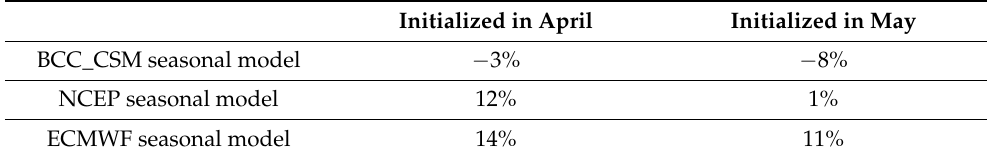
Figure 1. Prediction scores (PS) of different models initialized in different months, the three objective methods, and the operational products released by the NCC (National Climate Center) and SRCC (Shenyang Regional Climate Center). Table 1. Improving rate of the PS score of the models initialized in different months.